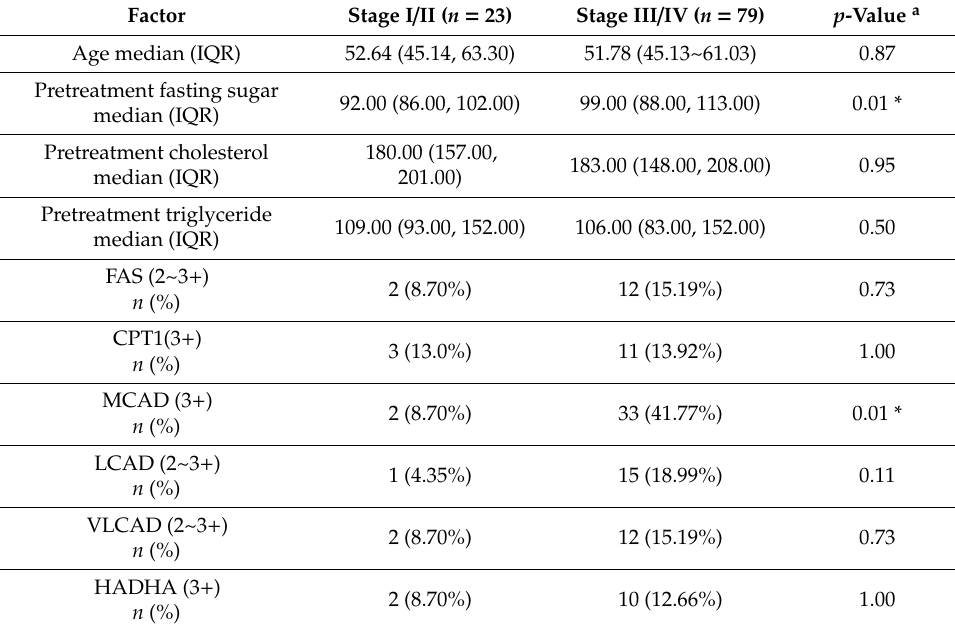
Table 3. Correlations between the clinical staging and patients’ characteristics ( n = 102).